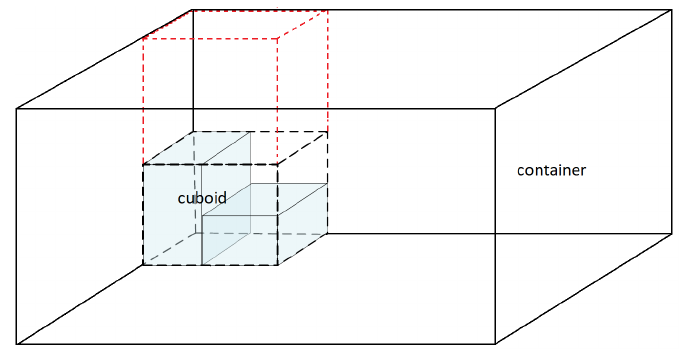
Figure 4. A representation of a guillotine block, its MBC, and the residual space on top of